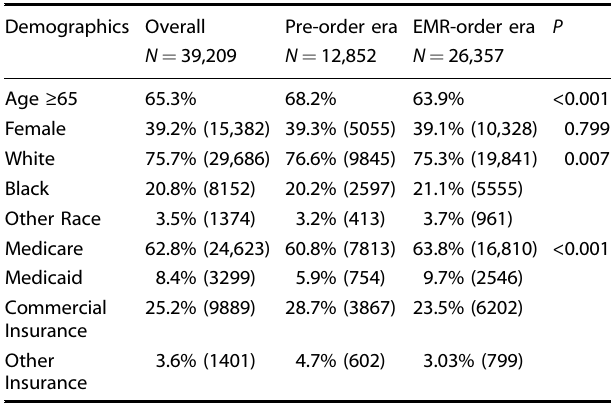
Table 1. Baseline demographics.